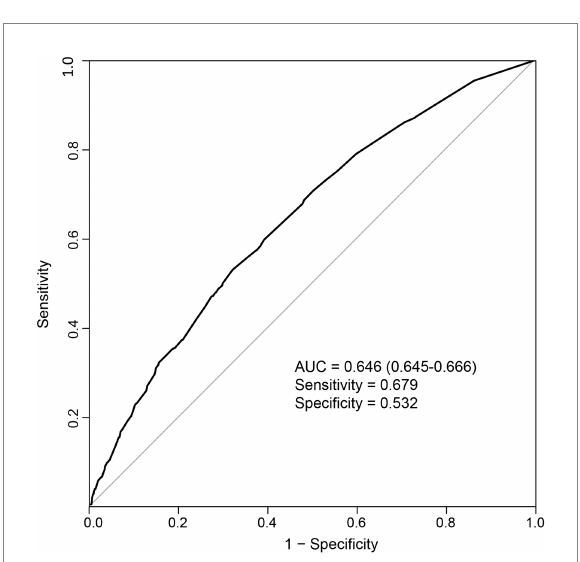
FIGURE 5 Receiver operating characteristic curve for the prediction model. AUC: area under the